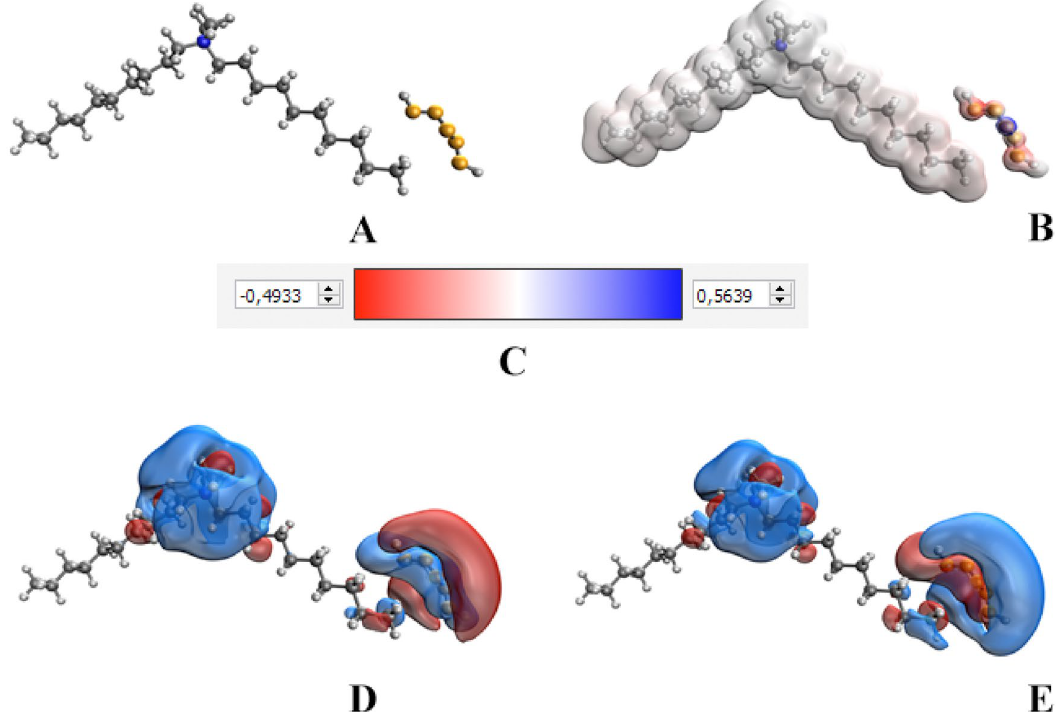
Figure 6. Results of quantum chemical modeling of Se NPs–DDAC: molecular complex model ( A ), electron density distribution ( B ), electron density distribution gradient ( C ), highest occupied molecular orbital HOMO ( D ), lowest unoccupied molecular orbital LUMO ( E